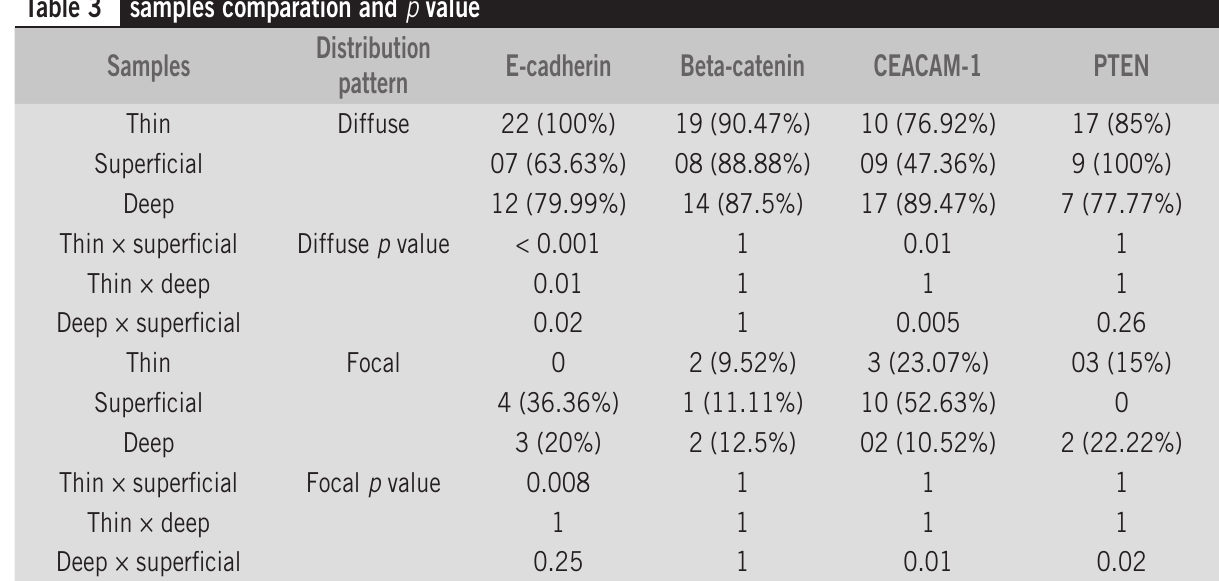
Distribution pattern (diffuse or focal) for positive immunohistochemical tests (with p value) in superficial and deep samples of thick melanomas ( n = 21) and in thin melanomas ( n = 22) with